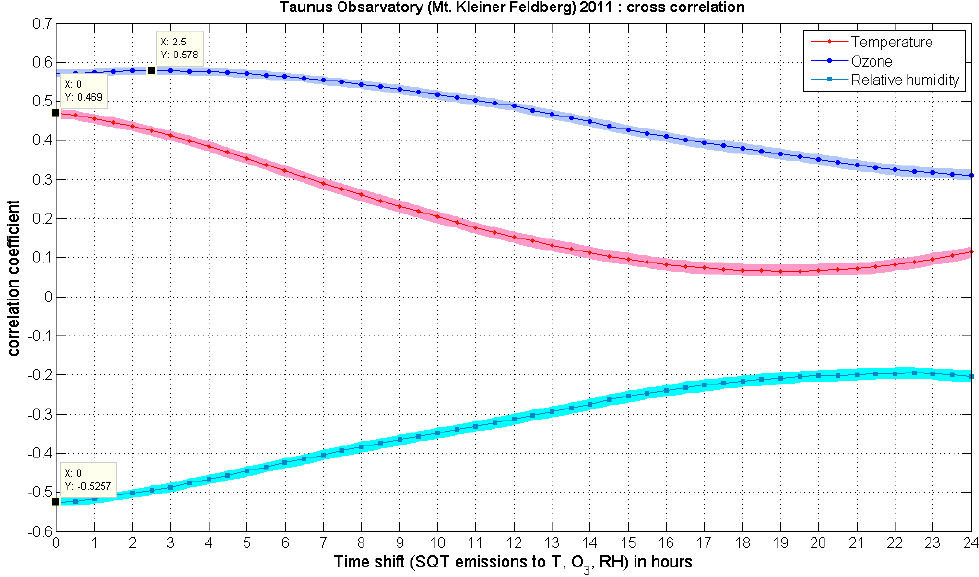
Fig. 3. Cross-correlation of SQT emission and temperature (red), ozone (blue) and relative humidity (cyan), with a time shift between the emissions and the individual stress